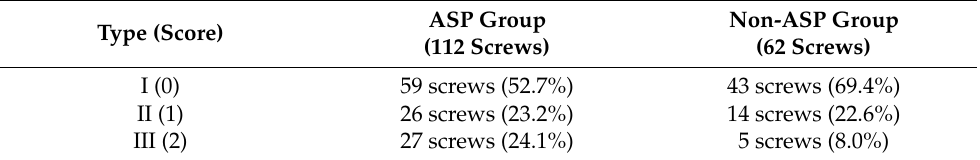
Table 3. Incidence of superior facet joint violation on CT scan in the ASP group and non-ASP group.